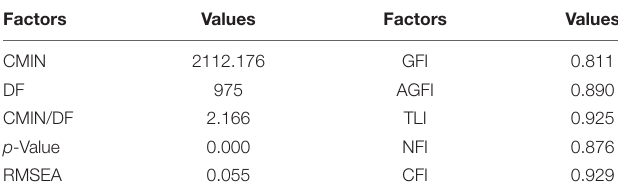
TABLE 4 | Model fit